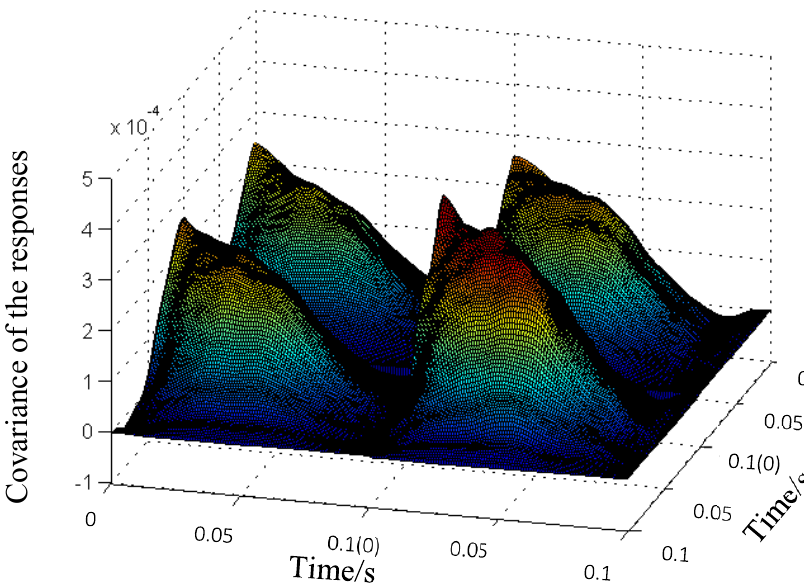
Figure 14. The equivalently calculated response covariance matrix.